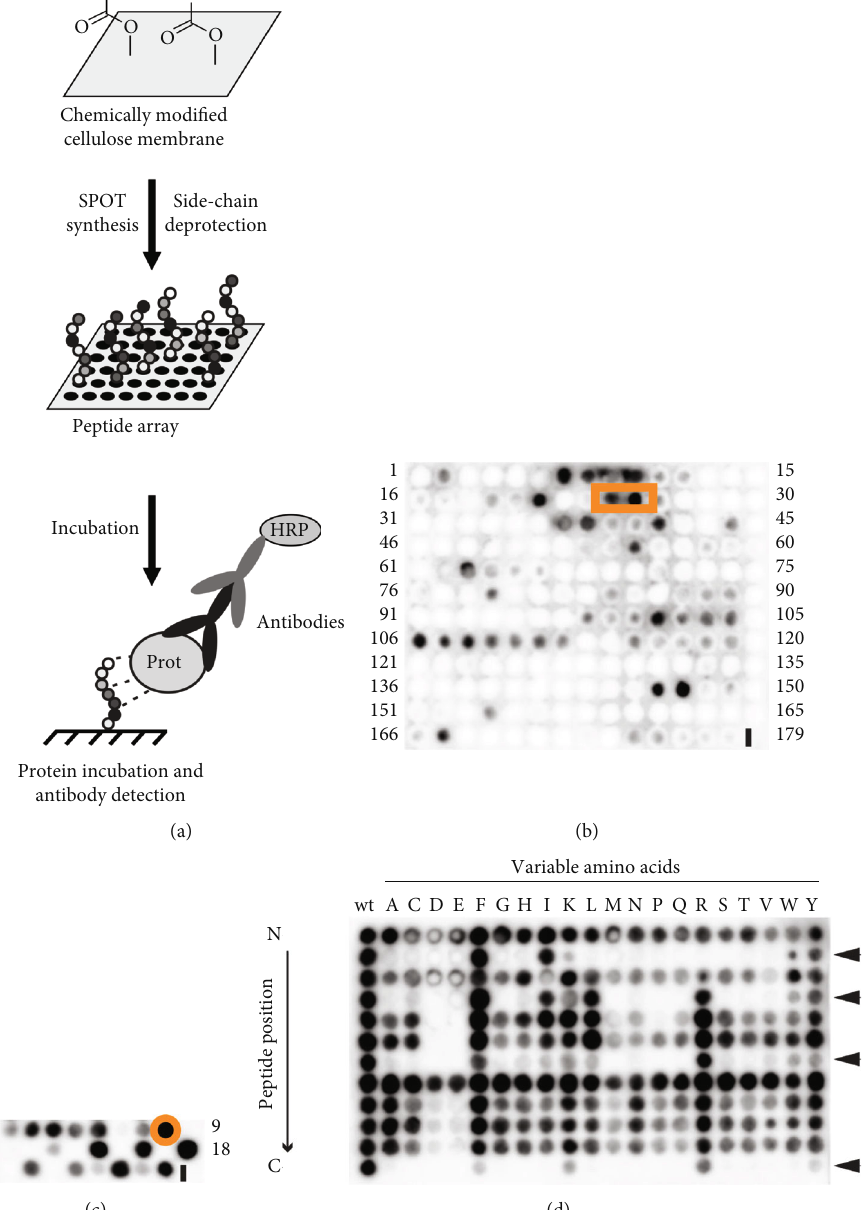
Figure 1: Determining a PPAR β / δ interfering peptide by SPOT synthesis. (a) General concept of the SPOT synthesis to synthesize membrane-bound peptides and of their protein incubation followed by antibody detection. (b) TF65 PepScan: primary sequence of the TF65 protein was dissected in overlapping peptides (15-mer with a shift of 3 amino acids) which were synthesized on the chemically modi fi ed cellulose membrane. Peptides were incubated with the His-tagged PPAR β / δ protein revealing a potent epitope corresponding to the spots n ° 24-25 (orange square). (c) Length analysis of the 18-mer peptide (spots n ° 24-25, cut at N- and C-terminus) showed the minimal peptide length (12-mer peptide of spot n ° 8, orange circle) required for TF65 binding. (d) Substitutional analysis of the 12- mer PP11 peptide revealed four key positions corresponding to the amino acids of isoleucine, leucine, lysine, and arginine (see